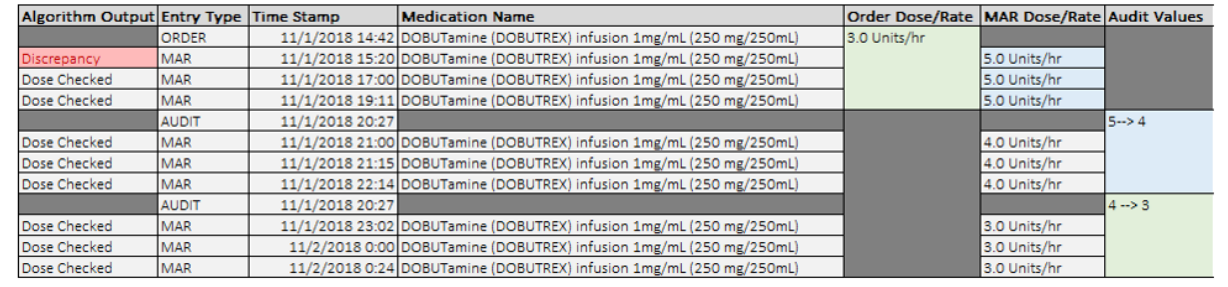
Figure 6. Example of an “order/audit value overwriting” issue leading to false positive calls from the system. Due to an ETL process, the original order value is repeatedly overwritten by the newer order audit values and ends up with the value of the last order audit record. When compared to the MAR documentations (which are correct), the false value in the order causes the algorithms to ‘detect’ a discrepancy, which is a false positive. ETL: extract, transform, load; MAR: medication administration